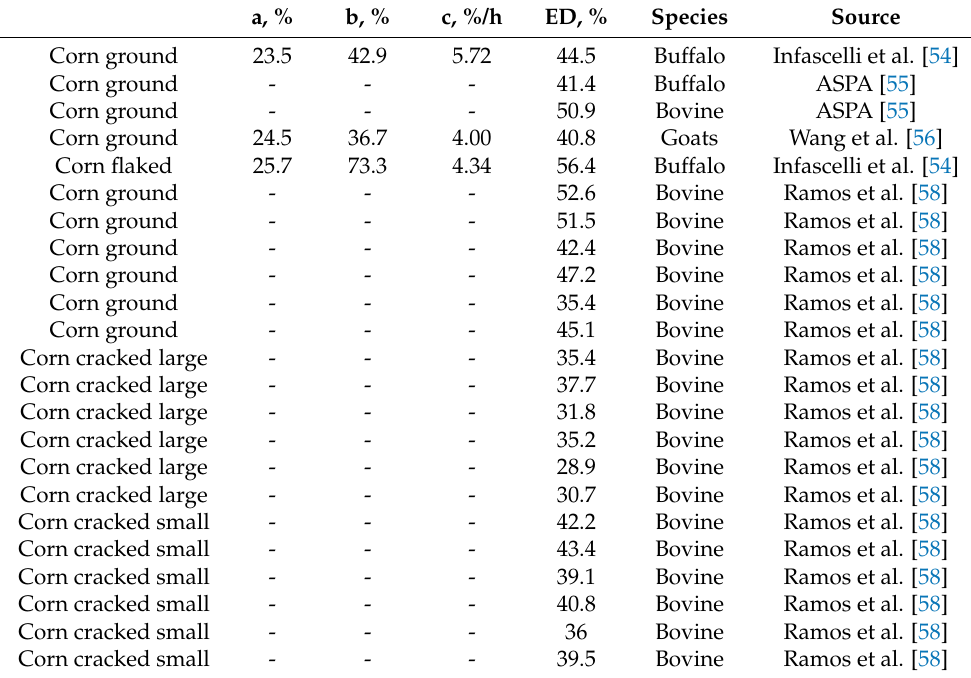
Table 3. Protein degradability of raw and treated corn